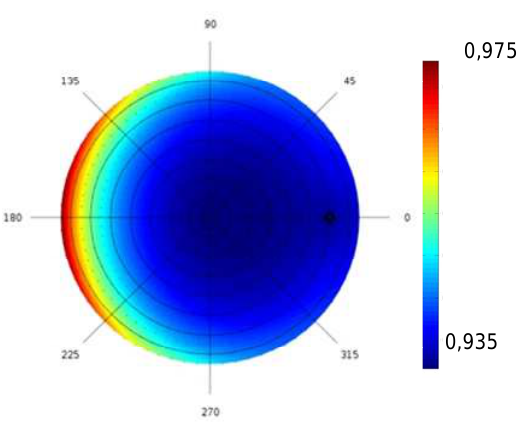
Figure 7 : On ground BRDF processed from PARASOL data on